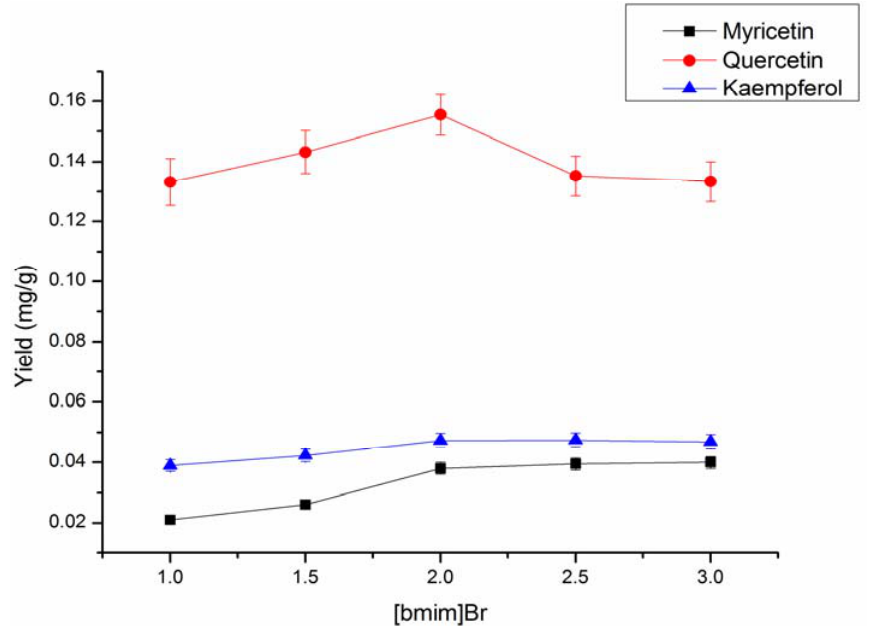
Figure 3. Effect of [bmim] Br concentrations on flavonoids extraction yields (Particle size: 0.30 to 0.45 mm; S/L ratio: 1:20; HCl: 0.8 mol/L). The range of [bmim] Br concentration was from 1.5 to 3.0